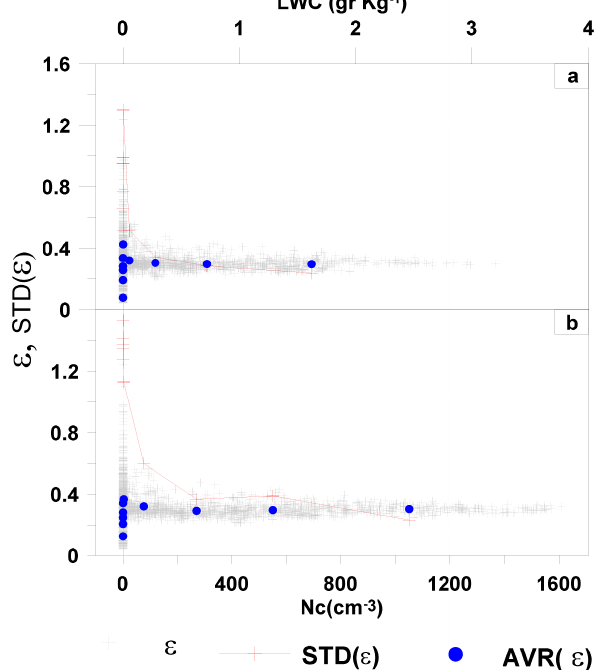
Figure 6. Relative dispersion and its variance as a function of cloud liquid water content (LWC) and droplet number ( N c ). Relative dis- persion ( ε ), relative dispersion average (AVR ( ε )) and relative dis- persion variance (STD ( ε )) are presented vs. LWC (a) and Nc (b) . AVR ( ε ) and STD ( ε ) are presented as the average values of 10 number-based size bins.